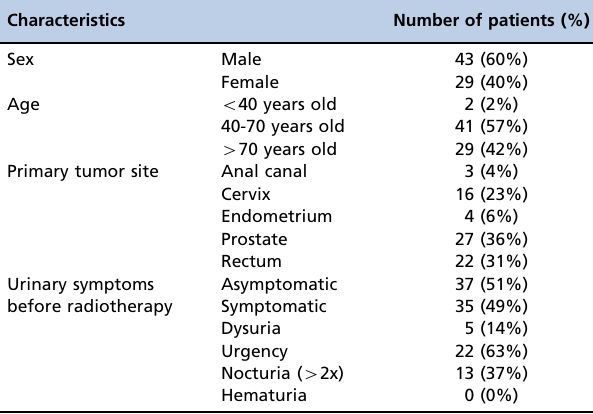
Table 1 - Characteristics of the 72 included